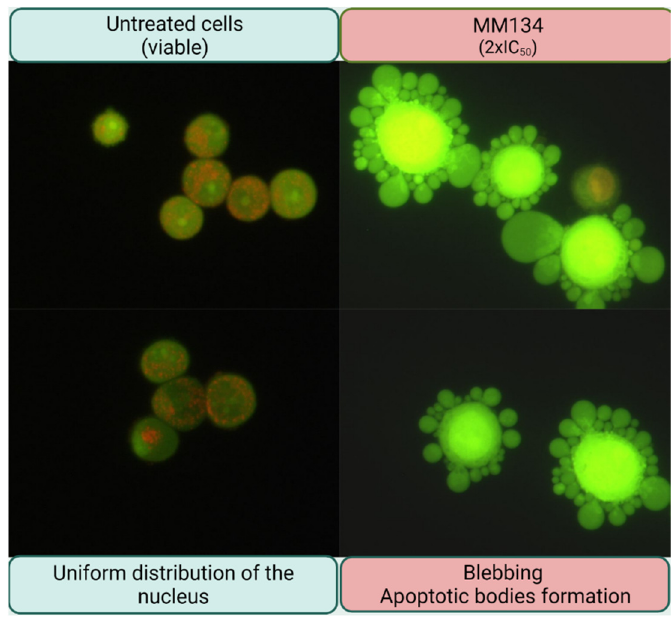
Figure 10. Typical morphological features of apoptosis in BxPC-3 following treatment with MM136 compound. Characteristic membrane blebbing can be observed in cancer cells after the treatment with the tested compound in 2xIC 50 concentration compared with cells from control group in which cells are rounded and exhibit uniformly distributed nucleus. Cells were visualized under a fluorescence microscope OLYMPUS BX60, magnification 40 ×